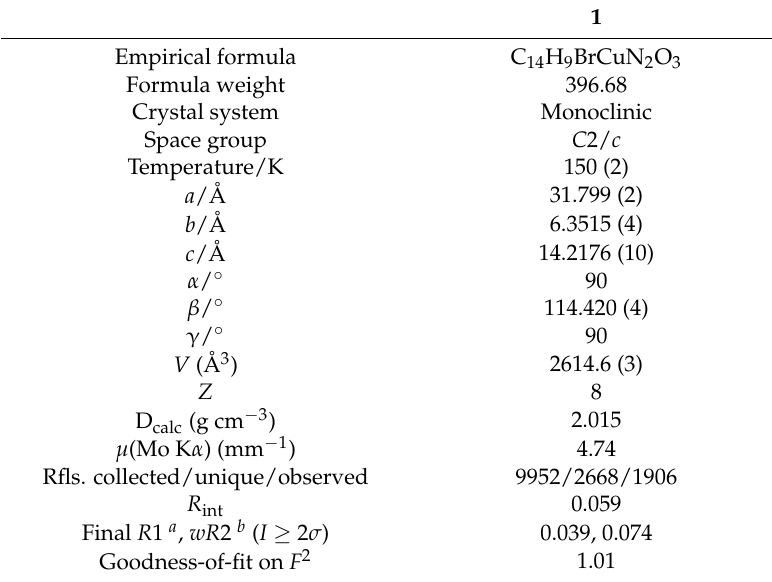
Table 1. Crystal data and structure refinement details for complex 1 .